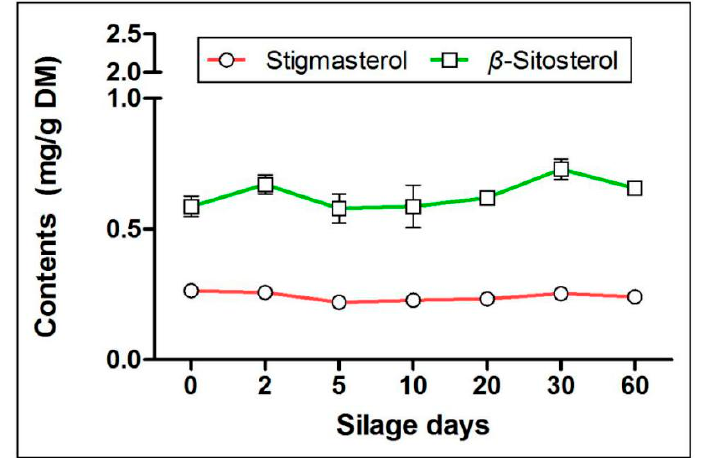
Figure 5. E ff ects of silage on sterols in artichoke Figure 5. Effects of silage on sterols in artichoke by-products. Figure 5. Effects of silage on sterols in artichoke by-products.